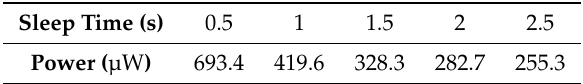
Figure 8. Bluetooth board current consumption profile in one Rx / Tx cycle. Table 2. Average bluetooth board power